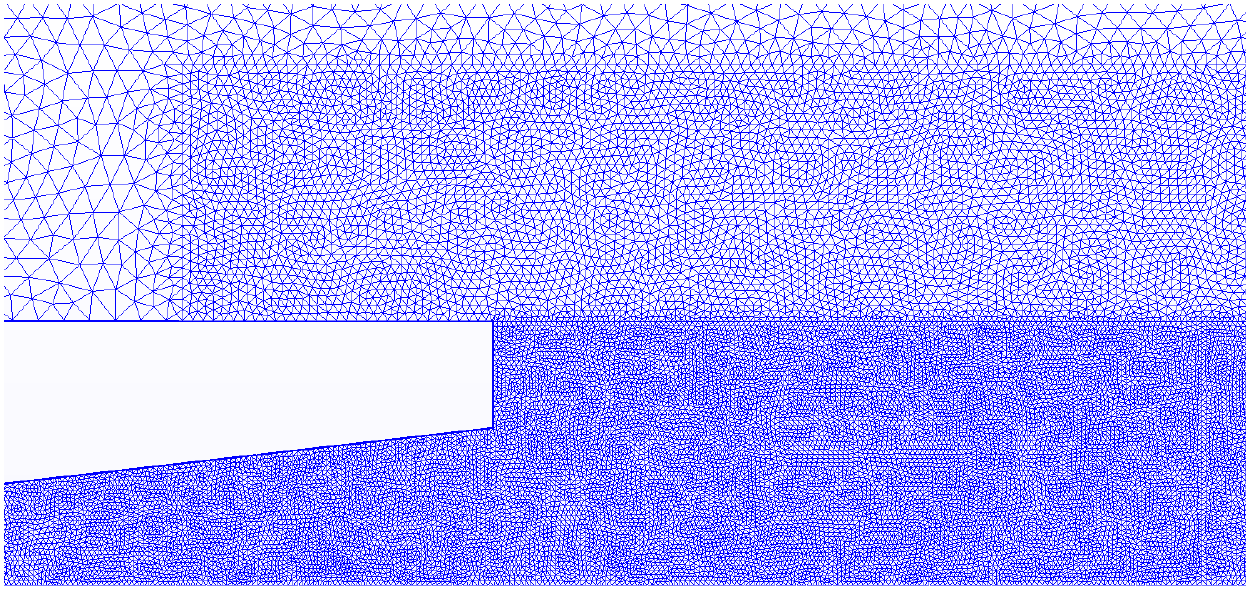
Figure 3. Mesh structure near nozzle exit. Size of elements: 0.1 mm, 0.2 mm, 0.5 mm.